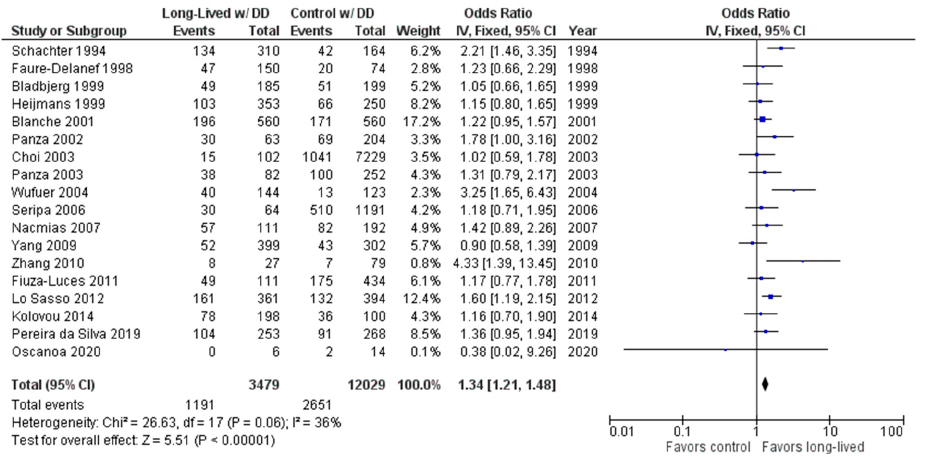
Figure 5. Comparison of DD genotype frequency in long-lived and control groups. The ages of long- lived and control groups are described in Table 1. The p- value is indicated by P in the Figure.